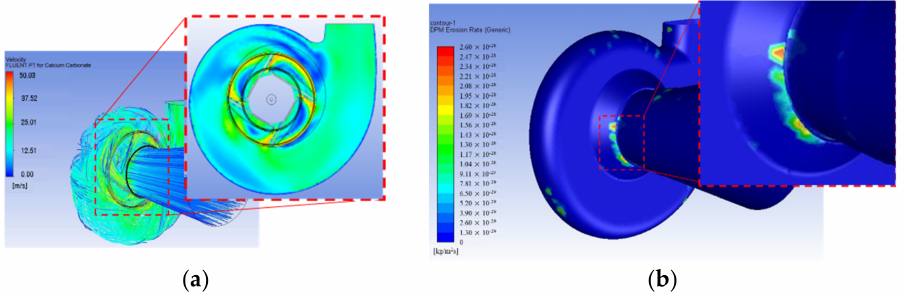
Figure 5. Simulation results: ( a ) slurry particles tracking and velocity streamlines; ( b ) erosion rate density.